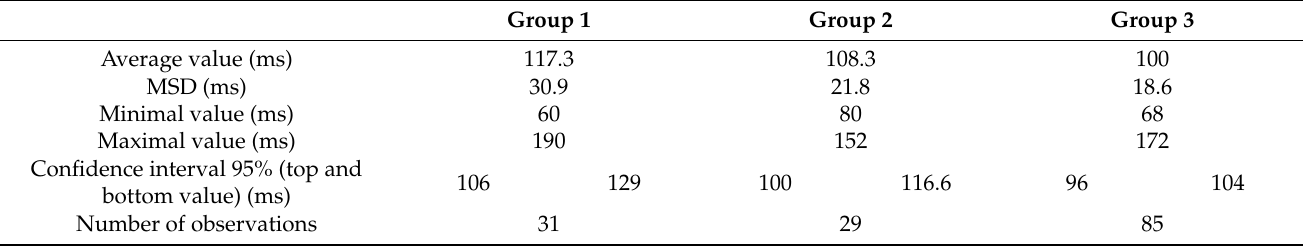
Figure 8. Differences between the groups by the duration of QRS complex; N—number of observa- tions, EF—ejection fraction, fQRS—fragmented QRS complex. Table 6. Distribution of patients in the studied groups depending on the duration of QRS com- plex.